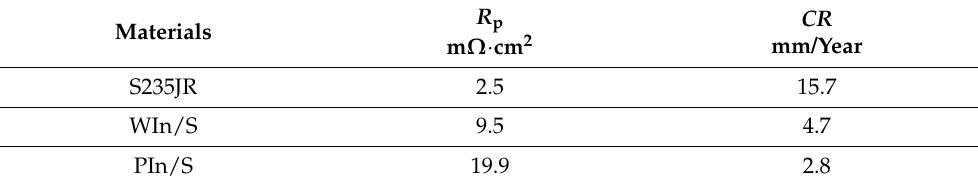
Table 6. Polarization resistance and corrosion rate of S235JR steel or Inconel 625 coatings.